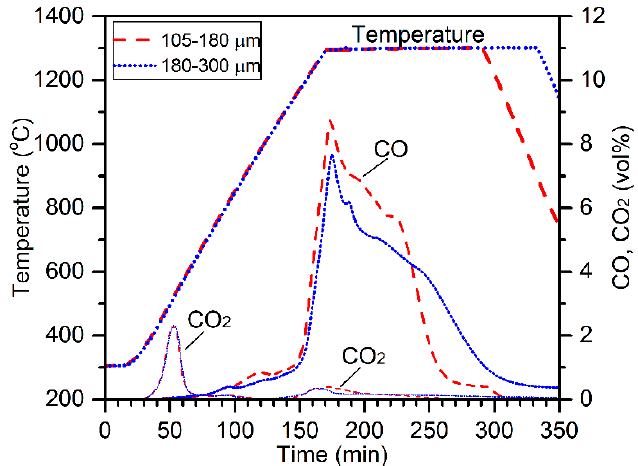
Figure 6. Temperature profiles and off-gas CO and CO 2 concentrations for the tests with the variation of charcoal particle size.